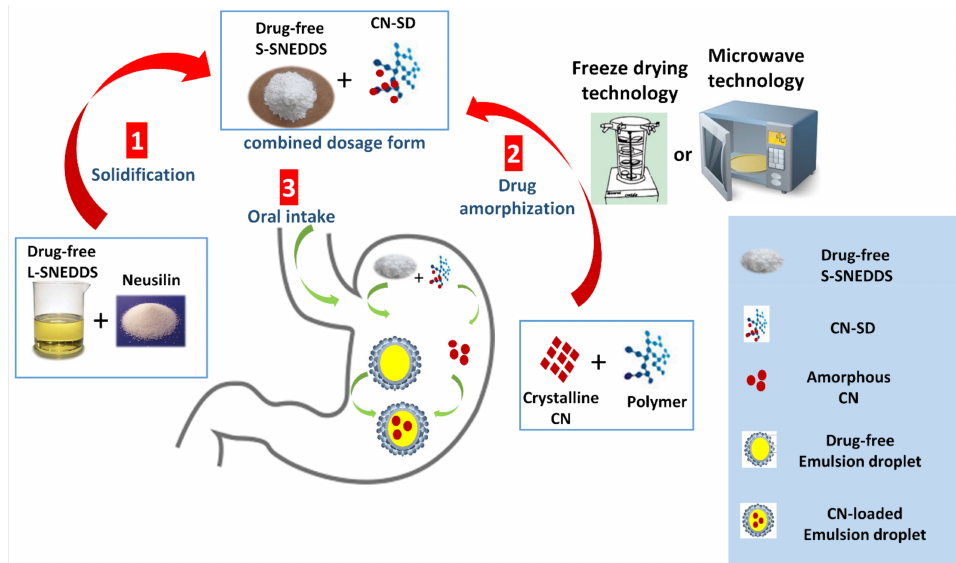
Figure 1. Schematic diagram of the manufacturing and performance of (CN-SD + drug free S-SNEDDS) combined dosage form. CN-SD denotes: cinnarizine-loaded drug dispersion; S-SNEDDS: solid self-nanoemulsifying drug delivery